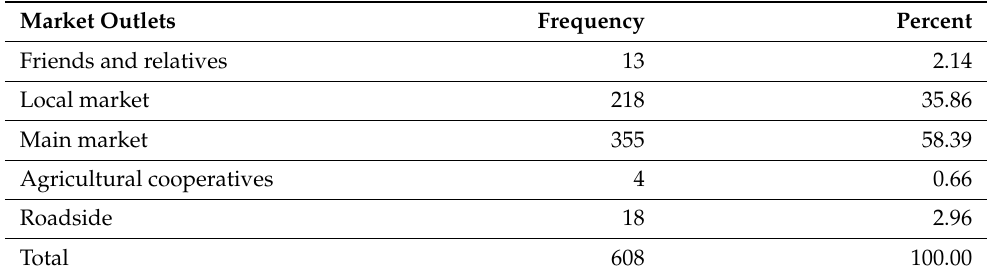
Table 1. The main market outlet